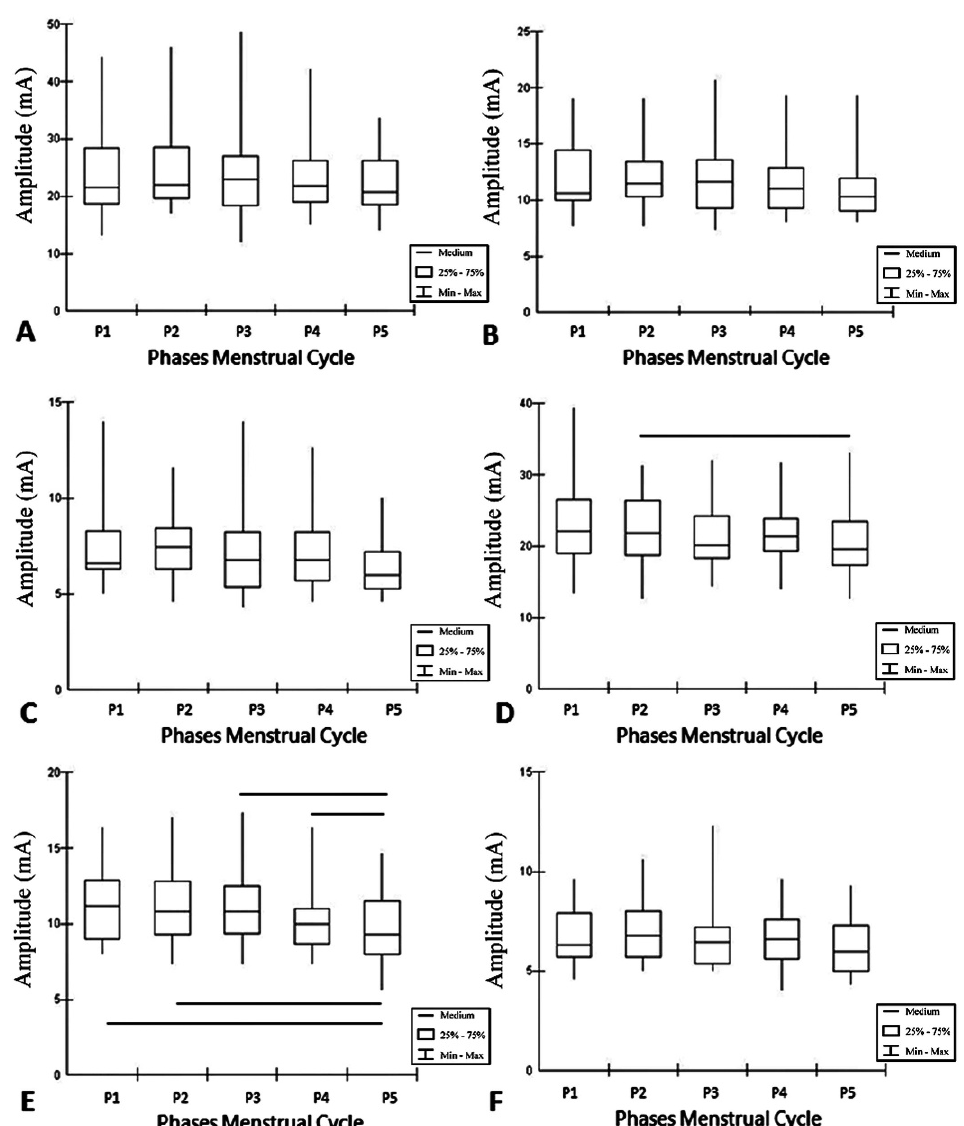
Figure 1 - The sensitivity threshold (ST) across the following five phases of the menstrual cycle (MC): menstrual (P1), follicular (P2), ovulatory (P3), luteal (P4) and premenstrual (P5). A current of 2,500 Hz was applied in phases of 20 m s (A and B), 50 m s (C and D) and 100 m s (E and F). A, C and E represent the non-oral contraceptive group (NOCG), and B, D and F represent the oral contraceptive group (OCG). The connections indicate statistical significance ( p